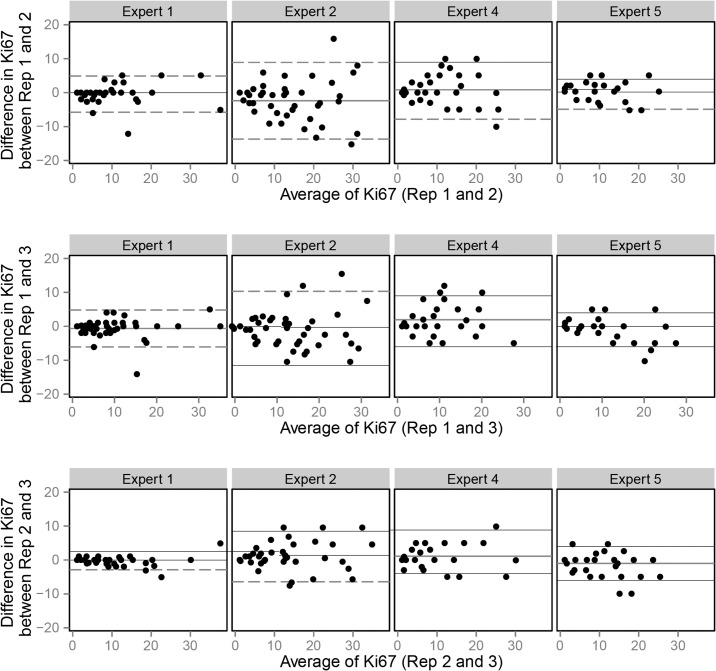
Bland Altmann plots for method A.